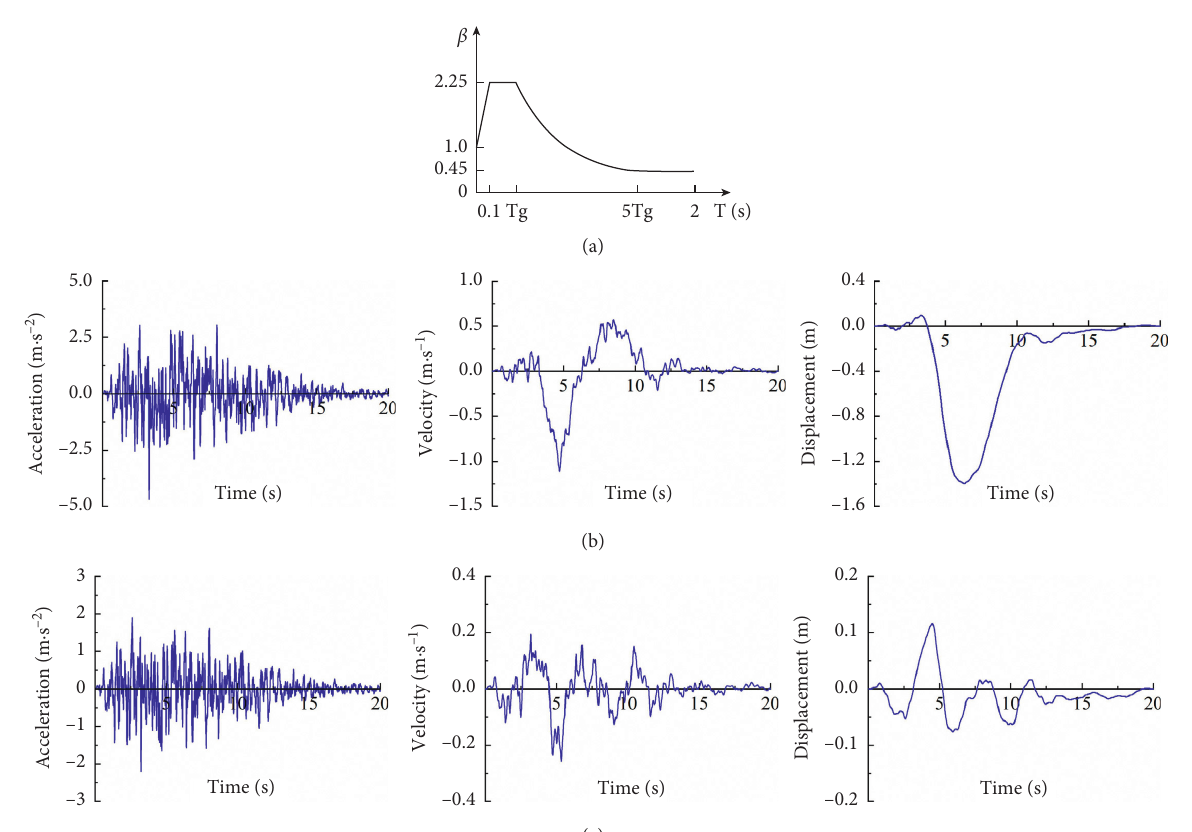
Figure 3: (a) The Zheduoshan tunnel site design response spectrum. (b) The time history curves of near-fault pulsed ground motion. (c) The time history curves of far-field ground motion. Table 2: The regression coefficients and the variance of T